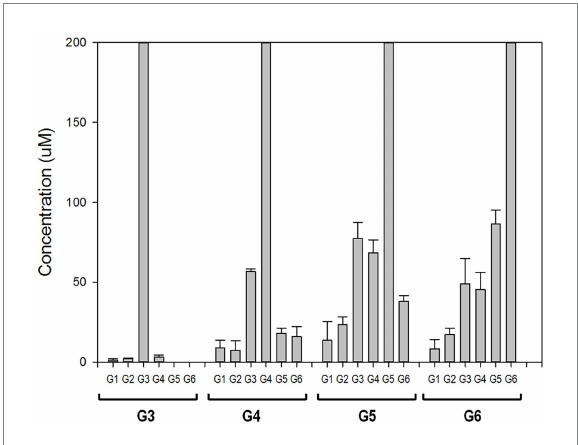
FIGURE 3 PSGT hydrolysis product distribution at initial reaction